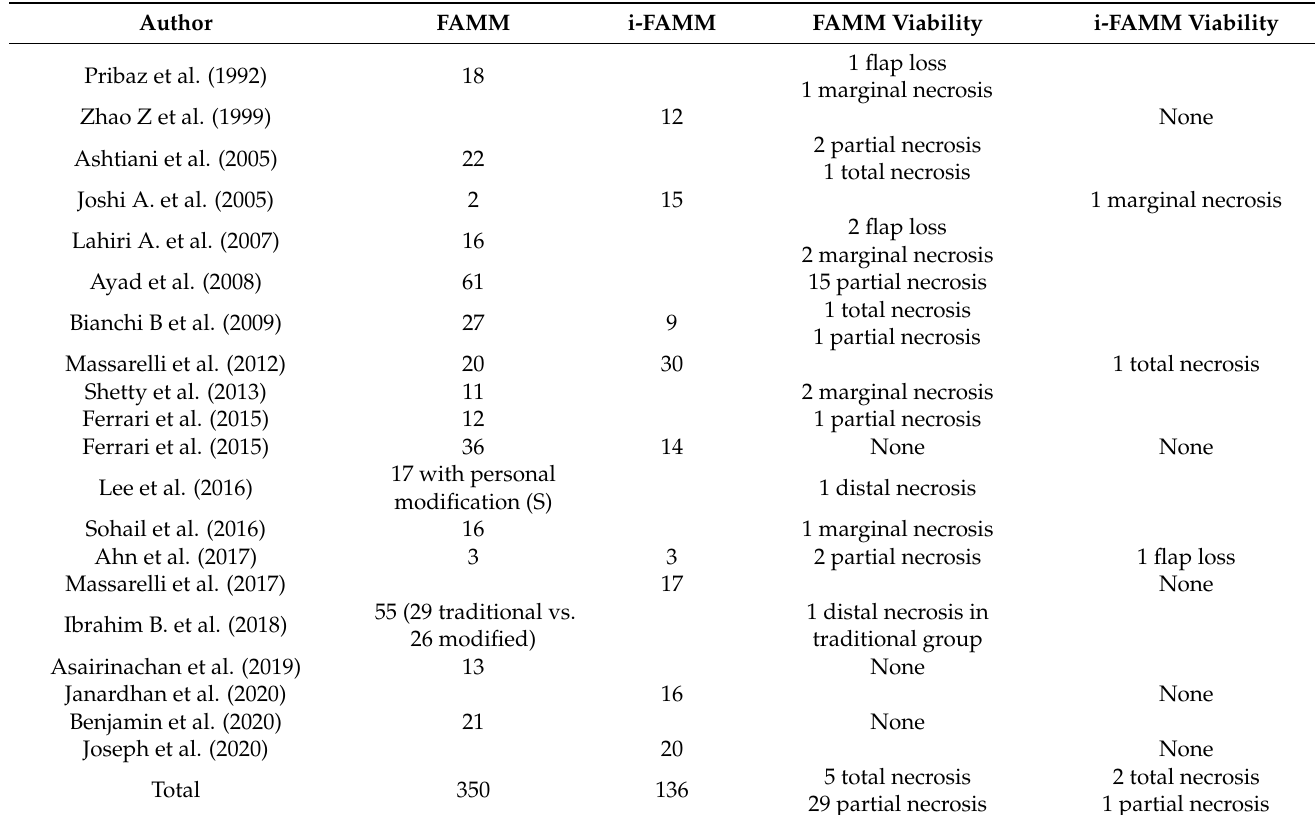
Figure 3. ROBINS-I Weighted Summary Plot bias assessment. Table 1. Synthesis of results.